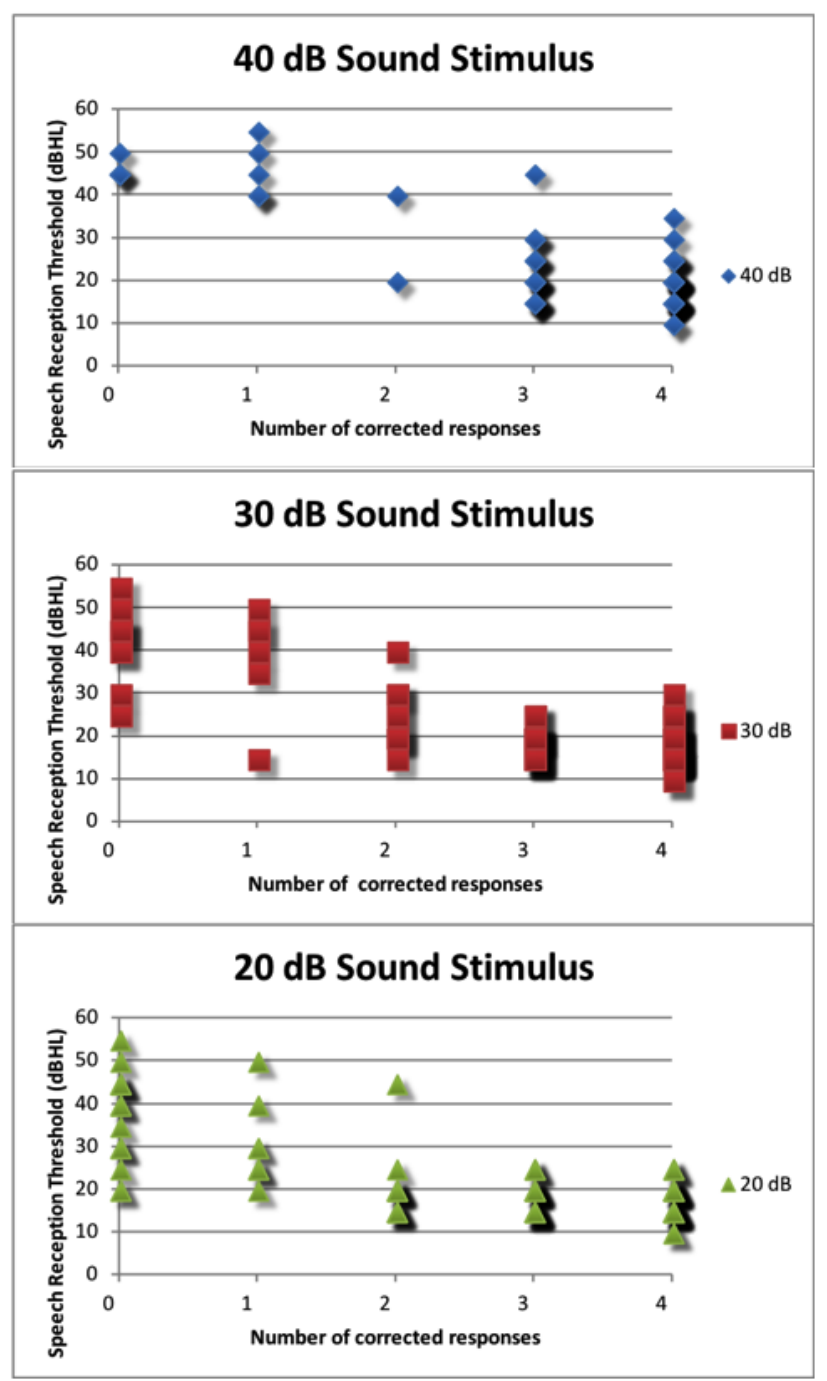
Figure 8. The relation of number of correction responses for each intensity and speech reception threshold. dBHL: decibels hearing